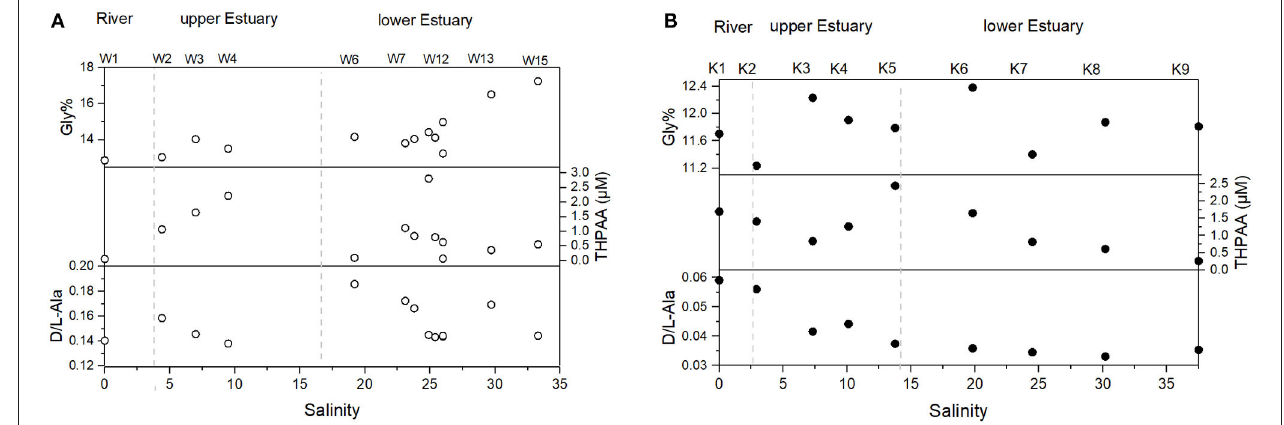
FIGURE 6 | Particulate OM composition (as revealed by amino acids) variation vs. salinity of the surface waters in (A) the WRE and (B) the KRE.